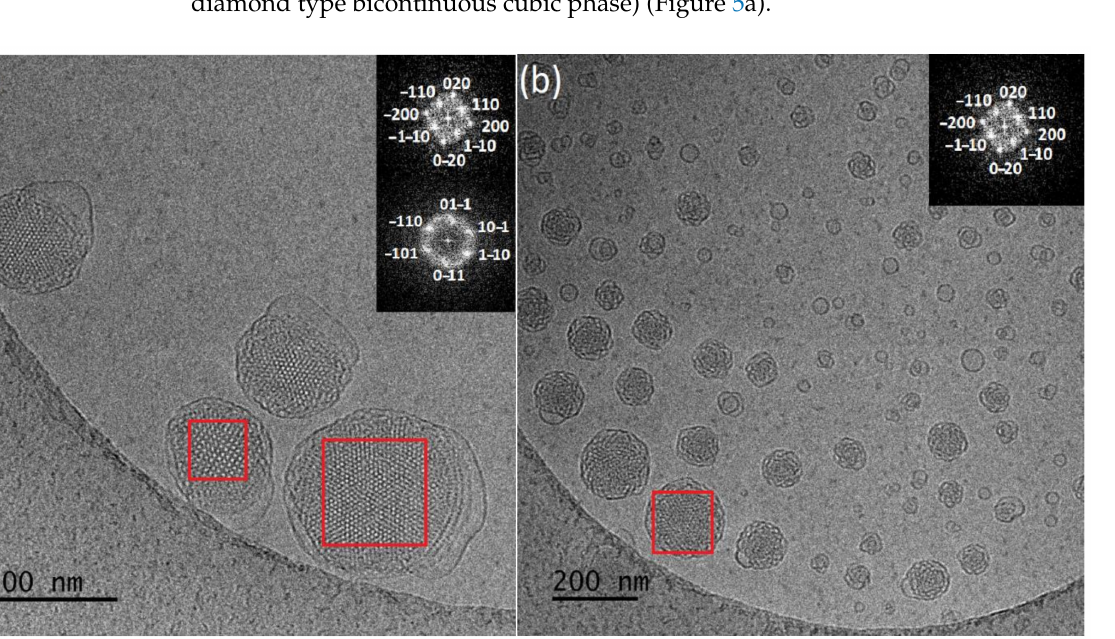
Figure 5. Fast Fourier transform (FFT) analysis of particles with ordered internal structure for ( a ) GMO:PEO- b -PMEC 9:1 + resveratrol, and ( b ) GMO:PEO- b -PMEC 4:1 +